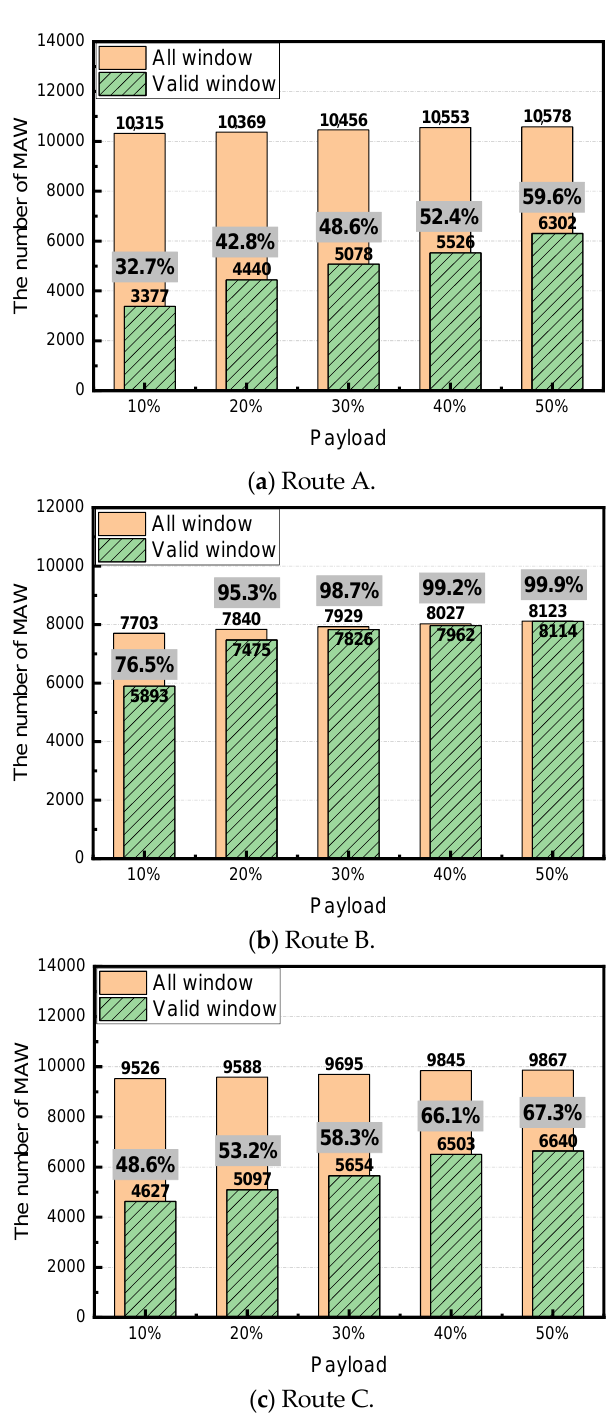
Figure 7. Number of MAWs and the ratio of the valid window with respect to payload for each route.